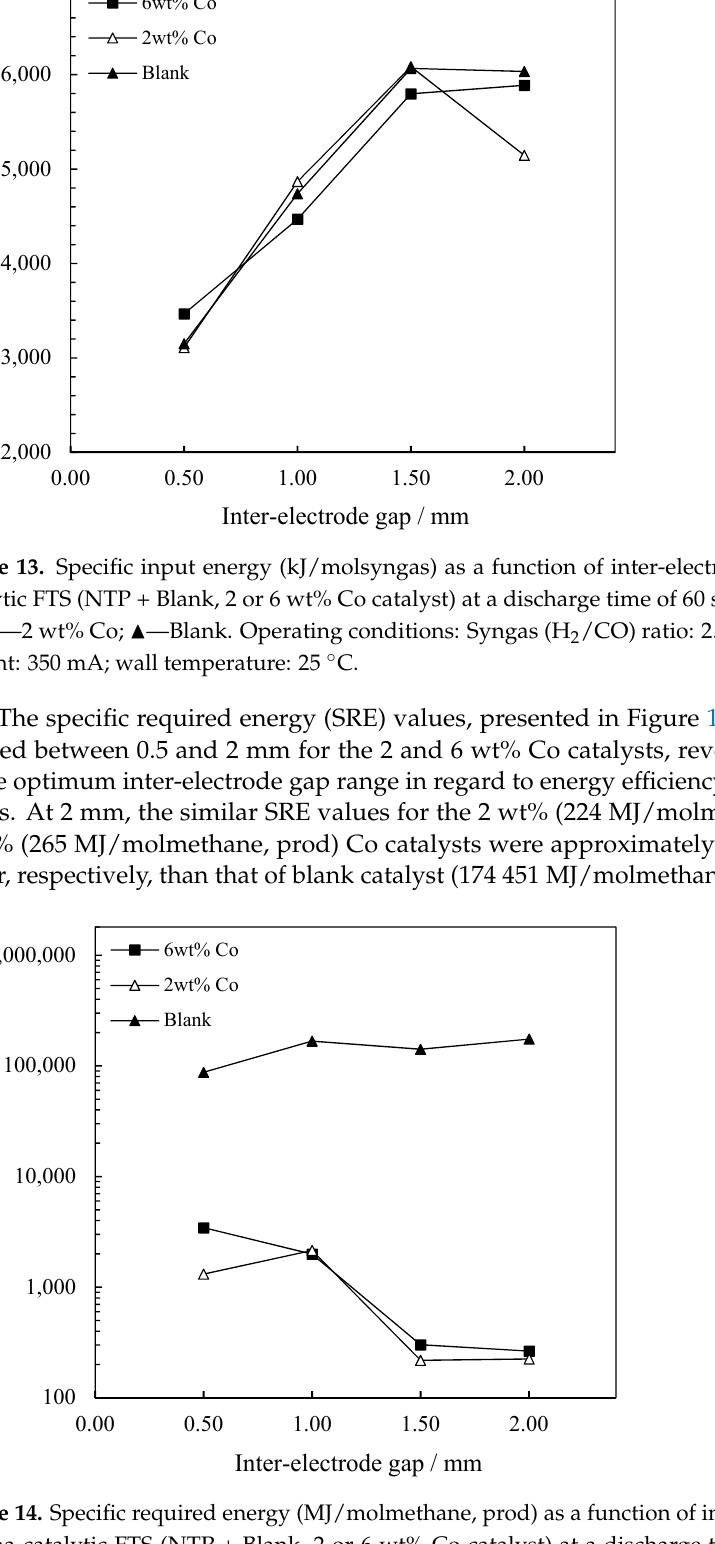
Figure 12. The influence of inter-electrode gap on rms voltage for plasma-catalytic FTS (NTP + Blank, 2 or 6 wt% Co catalyst) at a discharge time of 60 s. Legend: ■ —6 wt% Co; Δ —2 wt% Co; ▲ — Blank. Operating conditions: Syngas (H 2 /CO) ratio: 2.2:1; pressure: 2 MPa; current: 350 mA; wall temperature: 25 °C.